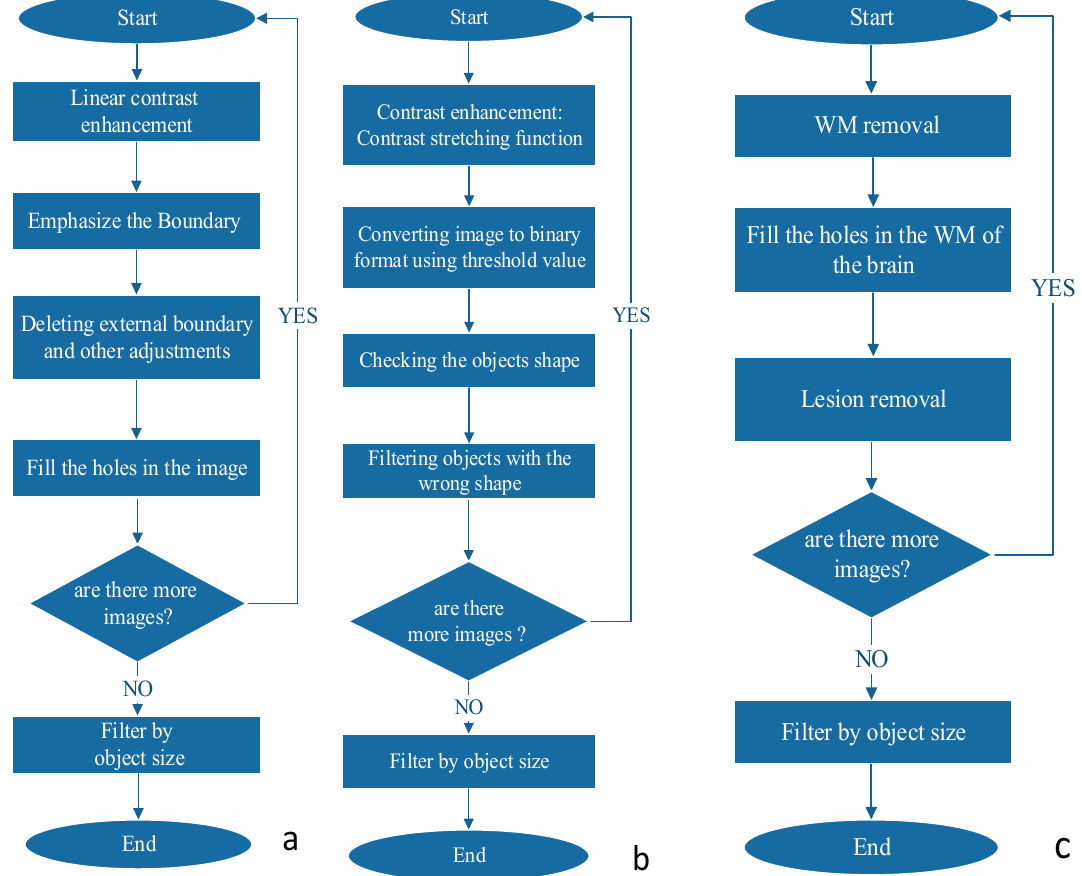
Figure 3. Detection algorithms: ( a ) boundaries detection scheme; ( b ) object shape detection scheme; ( c ) grayscale range detection